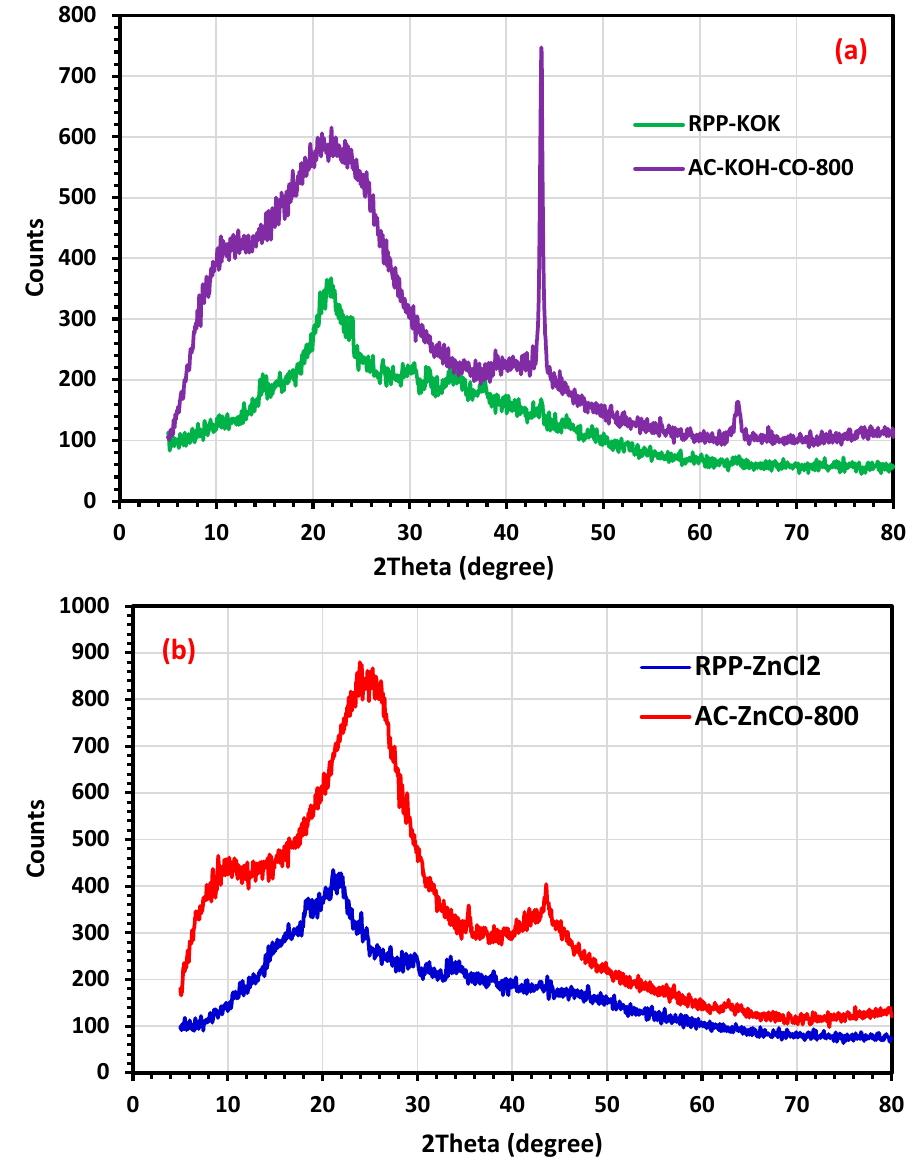
Figure 1. XRD analysis of ( a ) raw pea pods ( Pisum sativum ) impregnated with KOH (green) and activated carbon prepared with it via pyrolysis at 800 °C under flow of CO 2 (purple); ( b ) raw pea pods ( Pisum sativum ) impregnated with ZnCl 2 (blue) and activated carbon prepared with it via pyrolysis at 800 °C under flow of CO 2 (red).